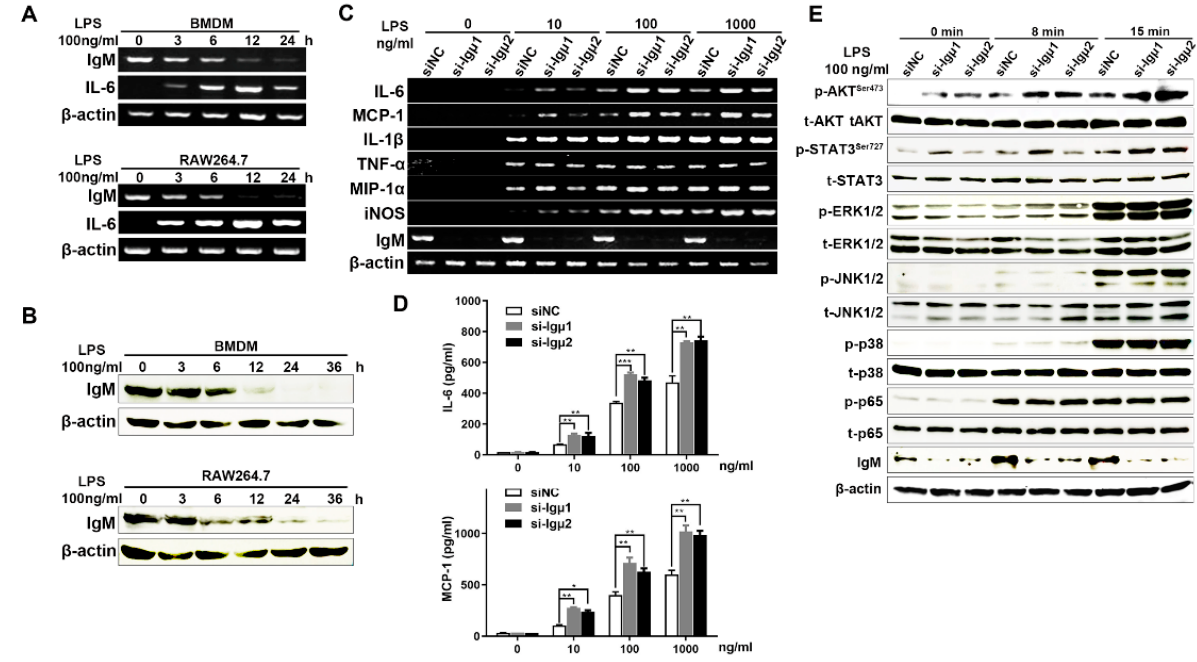
Figure 4. IgM knockdown promoted a pro-inflammatory effect in LPS-induced RAW264.7 macrophages through Akt signaling. The upregulated expression of IgM in BMDMs and RAW264.7 cells stimulated with 100 ng/mL LPS for 0, 3, 6, 12, and 24 h by RT-PCR ( A ) and Western blot ( B ). ( C ) Cells were transfected with IgM siRNA (si-Ig µ ) and control siRNA (siNC) for 36 h and treated with various concentrations of LPS (0, 1, 10, 100, and 1000 ng/mL) for an additional 3 h. The pro-inflammatory cytokines, including IL-6, MCP-1, IL-1 β , TNF- α , MIP-1 α , and iNOS, were determined by RT-PCR. IgM acted as positive control and β -actin as an internal control. ( D ) Cells were transfected with IgM siRNA (si-Ig µ ) and control siRNA (siNC) for 36 h and treated with LPS (0, 1, 10, 100, and 1000 ng/mL) for an additional 12 h. The production of IL-6 and MCP-1 cytokines was measured by ELISA kit using the microplate reader. The data are presented as means ± SD ( n = 3). (* p < 0.05 and ** p < 0.01, *** p < 0.001 vs. siNC control group). ( E ) Cells were transfected with IgM siRNA (si-Ig µ ) and control siRNA (siNC) for 36 h before exposure to LPS (100 g/mL) for 8 and 15 min. Enhanced effects of IgM knockdown on phosphorylation of AKT at Ser 473 and STAT3 at Ser 727 in LPS-induced RAW264.7 macrophages were shown by Western blot analysis, but no obvious effect on phosphorylation of ERK1/2, JNK1/2, p38, and p65 was shown. p, phosphorylated protein; t, total protein. IgM acted as positive control and β -actin as internal